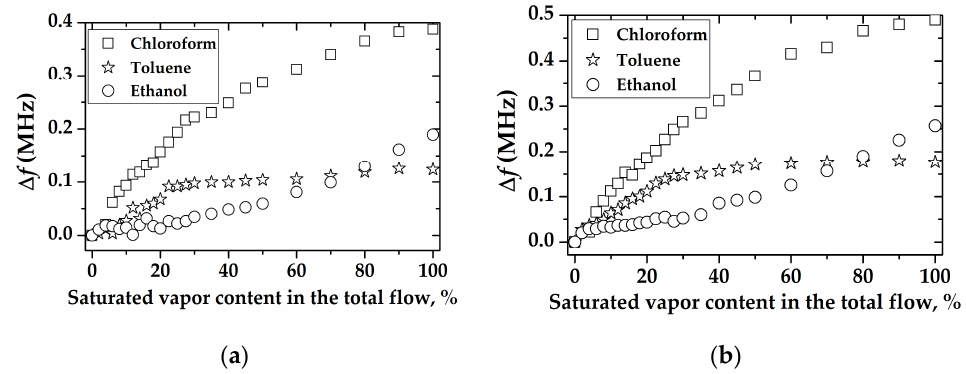
Figure 19. The changes in the frequency of the extrema from Figure 16 for ( a ) the S 12 parameter and ( b ) phase φ , versus different gas concentrations for device #1.